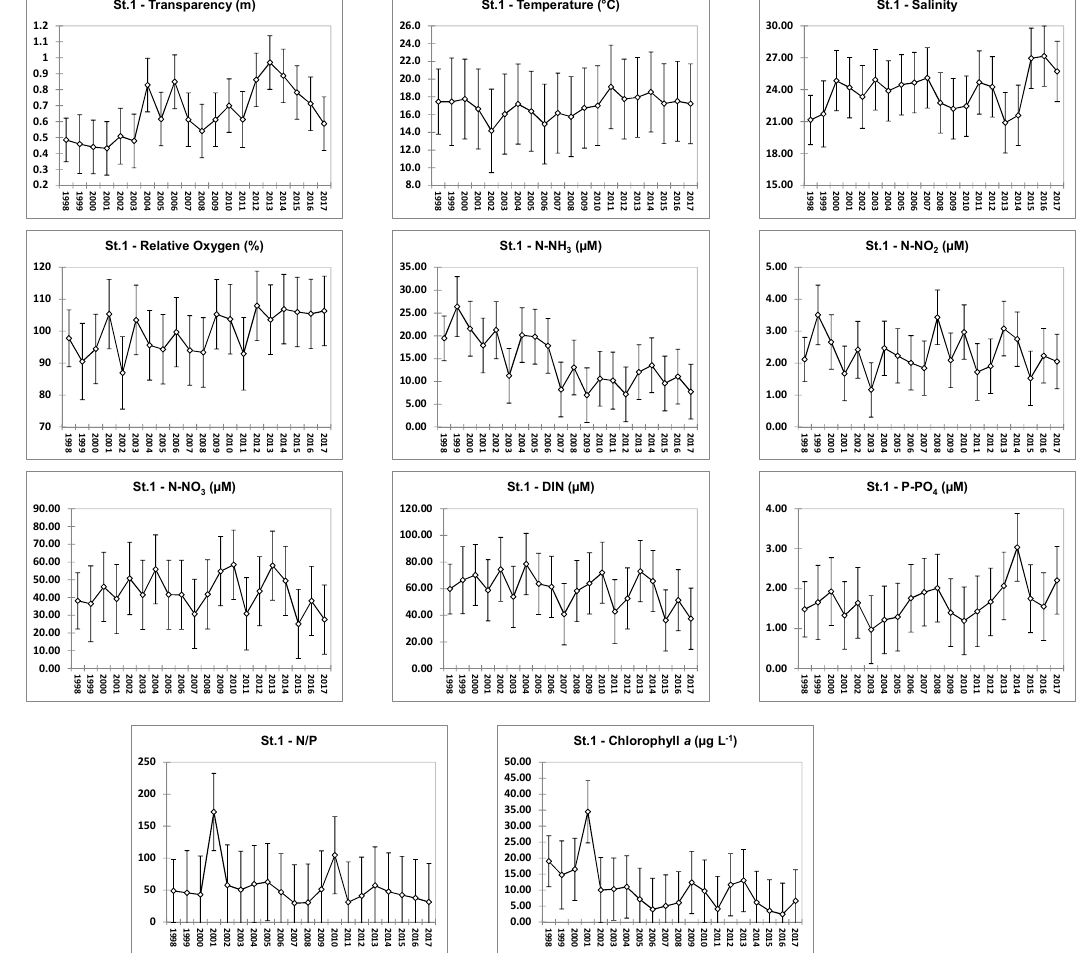
Figure 2. Yearly averages and confidence limits for hydrochemical parameters at St.1. Lower and upper bounds of means (95%) are shown.